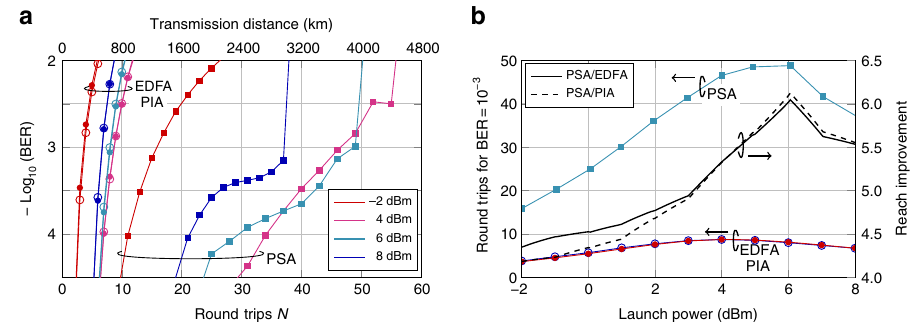
Fig. 4 BER characterization. a BER curves at various launch powers using in-line EDFA- ( fi lled circles), FOPA-PIA- (open circles), and FOPA-PSA-based ( fi lled squares) ampli fi cation. b Number of round trips giving a BER of 10 − 3 versus launch power and reach improvement comparing EDFA- ( fi lled circles) and FOPA-PIA-based (open circles) ampli fi cation to PSA-based ( fi lled squares) ampli